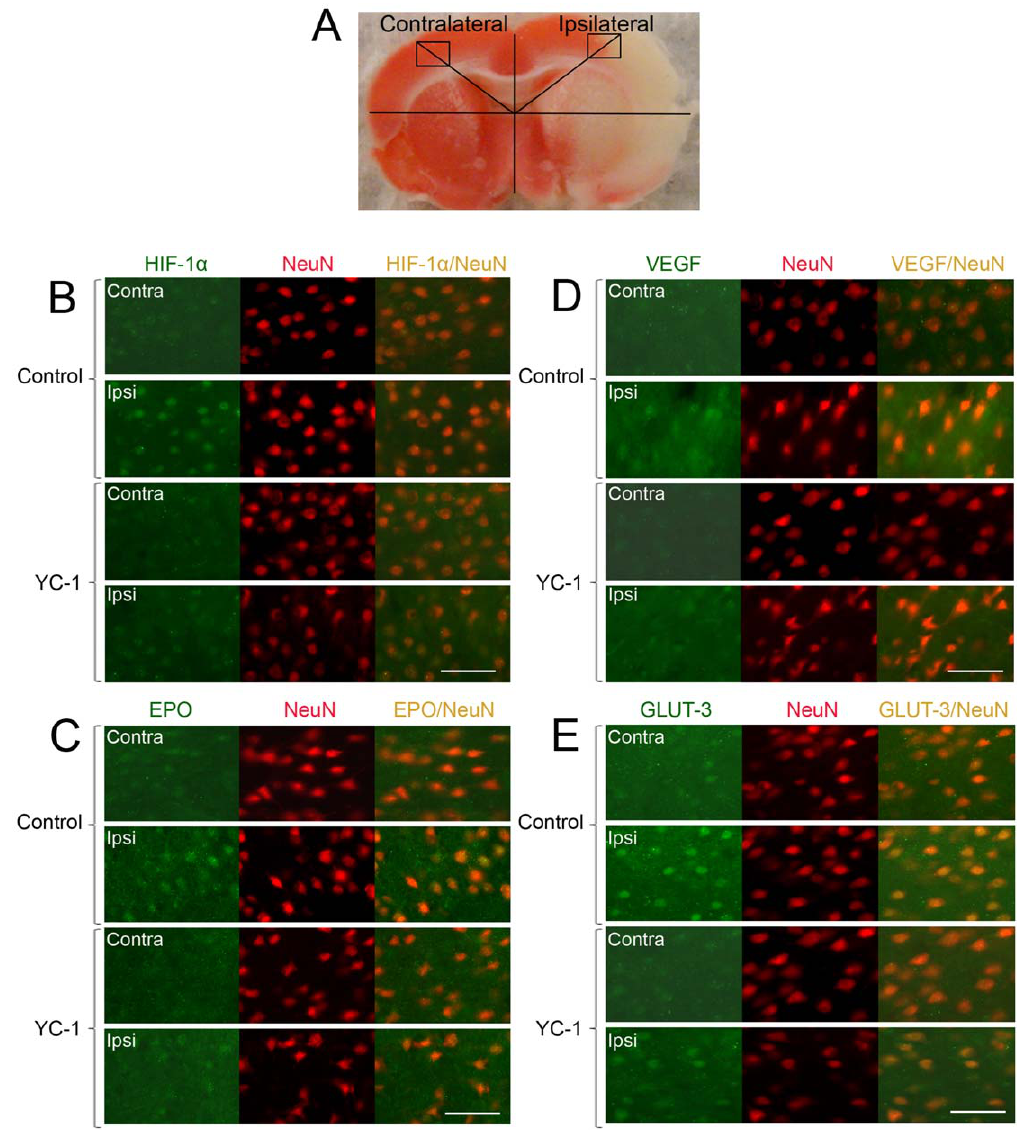
Figure 5. Effect of YC-1 on HIF-1 expression in neurons in ischemic brains. The protein levels of HIF-1 a and its down-stream genes were analyzed by double immunostaining with the neuronal marker NeuN after rats were subjected to 90 min ischemia and 24 hr reperfusion. Rats received YC-1 (2 mg/kg, i.v.) at 24 h and 30 min prior to the onset of ischemia. ( A ) TTC-stained rat brain coronal section. Labeled square areas represent locations of immuno images. ( B ) Double immunostaining of HIF-1 a (green) and NeuN (red). ( C ) Double immunostaining of EPO (green) and NeuN (red). ( D ) Double immunostaining of VEGF (green) and NeuN (red). ( E ) Double immunostaining of GLUT-3 (green) and NeuN (red). Scale bar, 53 m